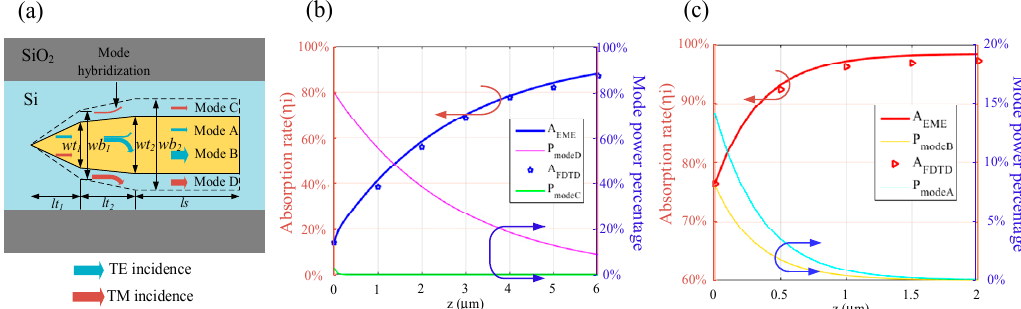
Figure 5. ( a ) Diagrammatic sketch of the mode propagation and conversion process under TE and TM incidence in dual-layer metal structure; ( b , c ) fitting results of the hybrid modes of power and absorption rate varied with the mode propagation length after the mode hybridization area, which are deduced by FDTD method and eigenmode expansion (EME) method, respectively. Structure parameters: ( b ) Au, h m = 6 nm, wt 1 = 0.07 µ m, wt 2 = 0.082 µ m, wb 1 = 0.17 µ m, wb 2 = 0.182 µ m, lt 1 = 0.2 µ m, lt 2 = 0.5 µ m, ls = 6 µ m; ( c ) TM incidence. Structure parameters: Au, h m = 12 nm, wt 1 = 0.135 µ m, wt 2 = 0.14 µ